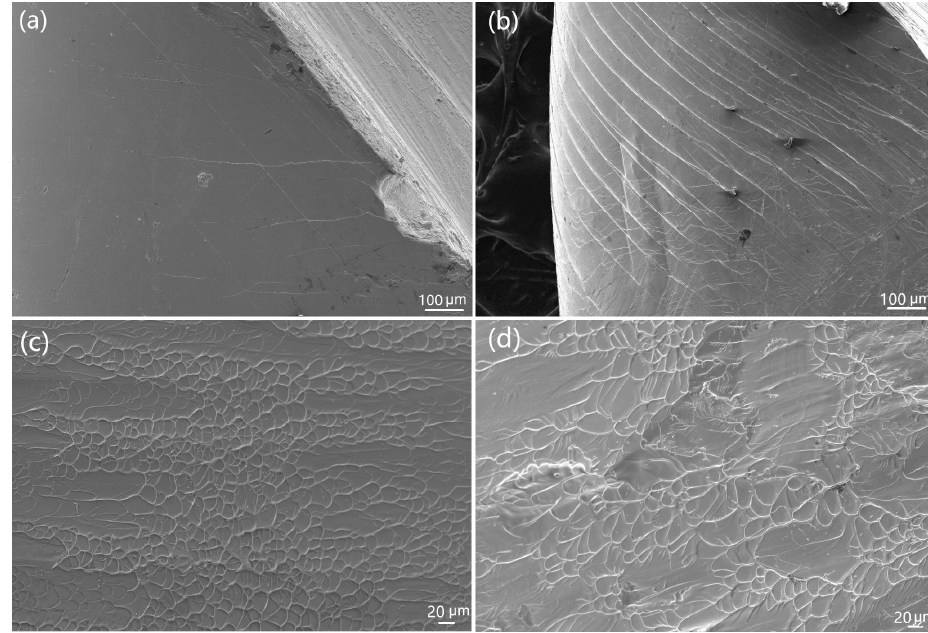
Figure 3. SEM micrographs of the lateral and fracture for Zr 52 Cu 42.5 Al 5.5 BMG ( a , c ) and Zr 52 Cu 42 Al 5.5 Nb 0.5 BMG composite ( b , d ).